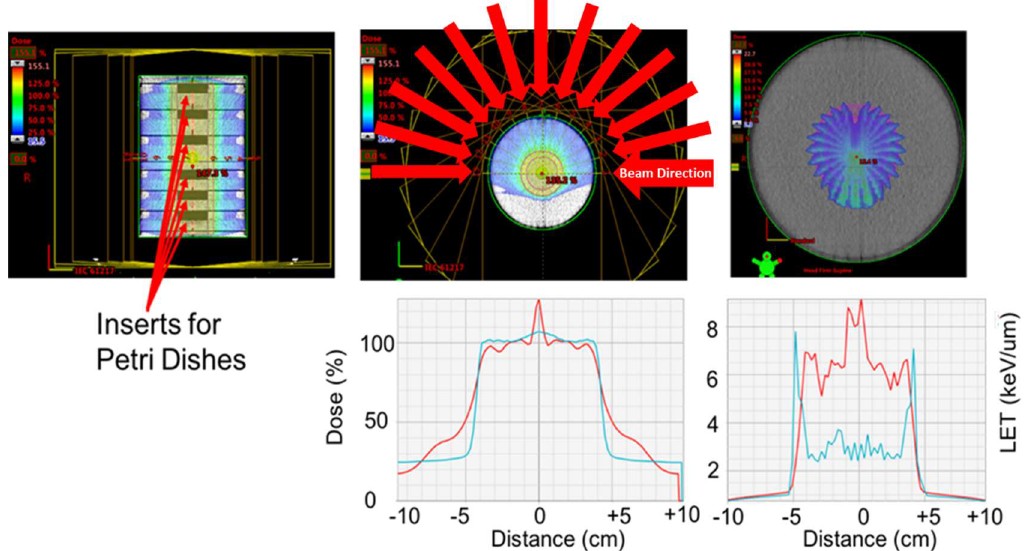
Figure 5. Geometry used to irradiate the cells with 0.5 and 0.25 Gy of protons, while maximizing the LET within the petri dishes. Top-left: CT image cross-section of the cylindrical phantom. The phantom is composed of six individual blocks made of solid water. Solid water phantoms are made of epoxy resins and powders to control density and radiation properties of the phantom and are traditionally used for dosimetry purposes. Each block was of 200 mm in diameter and 30 mm in depth. The blocks had a 60 mm insert centered in the central axis of the block, where the petri dishes were placed for the exposure. Each proton beam used had a vertical extension beyond the petri dish holder. Top-center: Color-wash of the proton dose distribution produced by 13 concentric and co-planar proton beams of 101 mm range. The 13 beams were delivered over an arc of 180 degrees and were separated every 15 degrees. Each beam only used a single energy of 117.14 MeV. Top-right: color-wash figure showing the Linear Energy Transfer distribution of the beam arrangement use. The image shows the LET increase at the distal falloff of each beam. Bottom-left: dose profile across the central plane of the cylinder (red line). The dose coverage extended 1 cm beyond the edges of the inserts to ensure the dishes received 100% of the dose. The blue line represents the dose profile that would be obtained if the beams had a Spread of Bragg Peak (SOBP), which improves the homogeneity of the dose. Bottom-right: Profile of the LET distribution across the target. The LET using the monoenergetic beams is higher within the Petri dishes, compared with the SOBP beams. Int. J. Mol. Sci. 2019 , 20 FOR PEER REVIEW